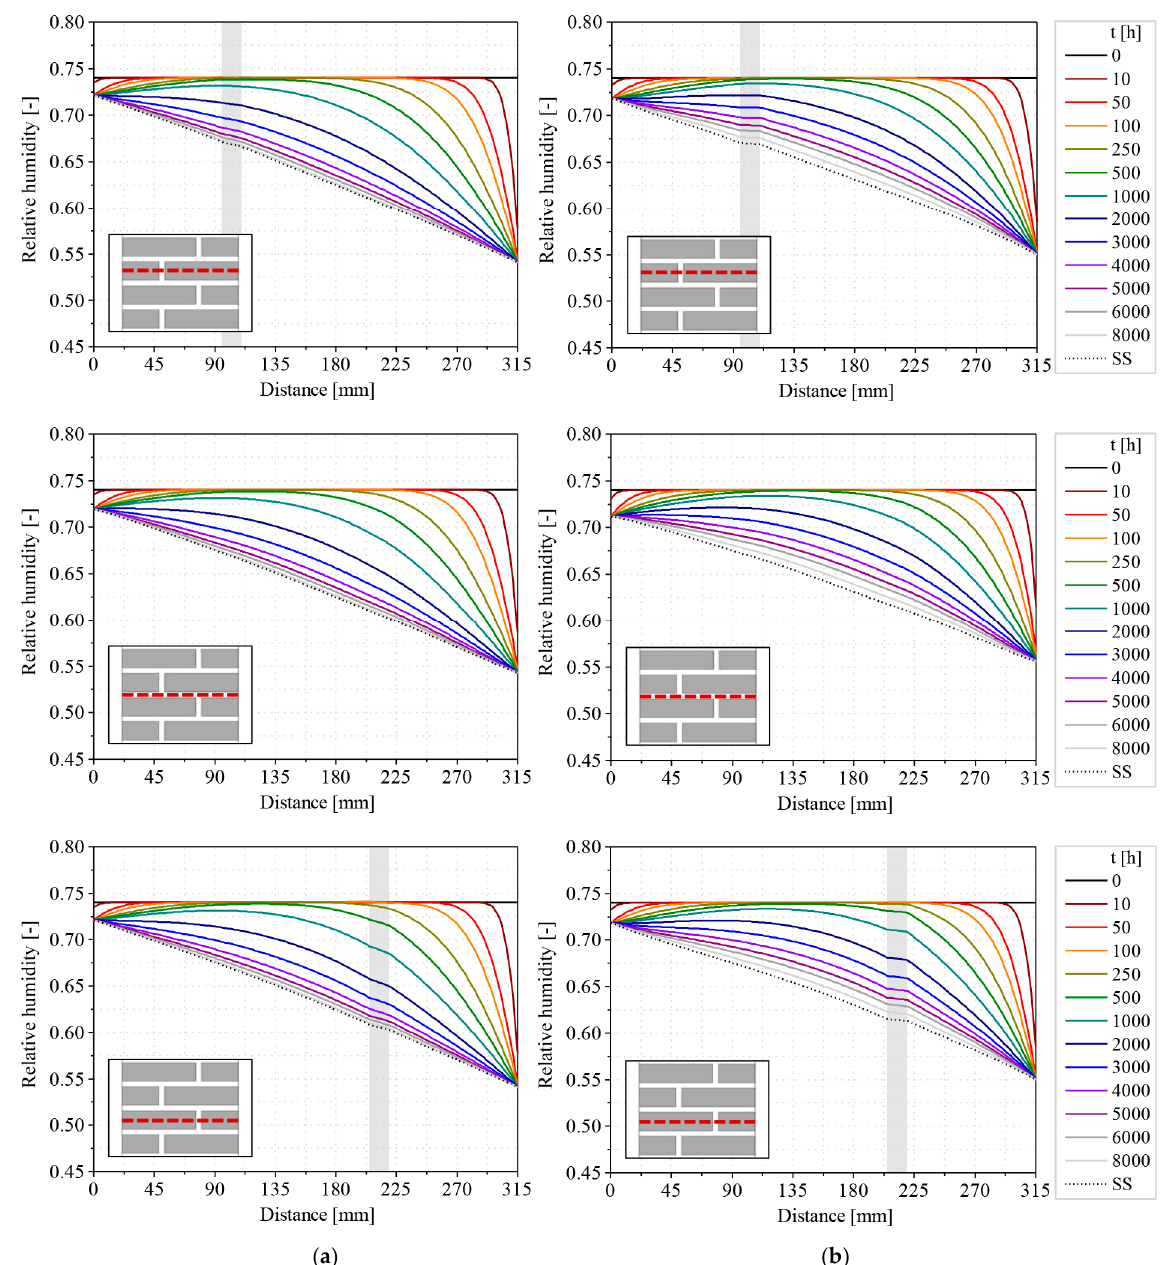
Figure 6. Time-dependent analysis (TD1). Evolution of the relative humidity across the studied three-wythe brick masonry wall: ( a ) joints with natural hydraulic lime mortar (LM); ( b ) joints with cement mortar (CM). Lines A–A’ ( top ), B–B’ ( middle ), and C–C’ ( bottom ).